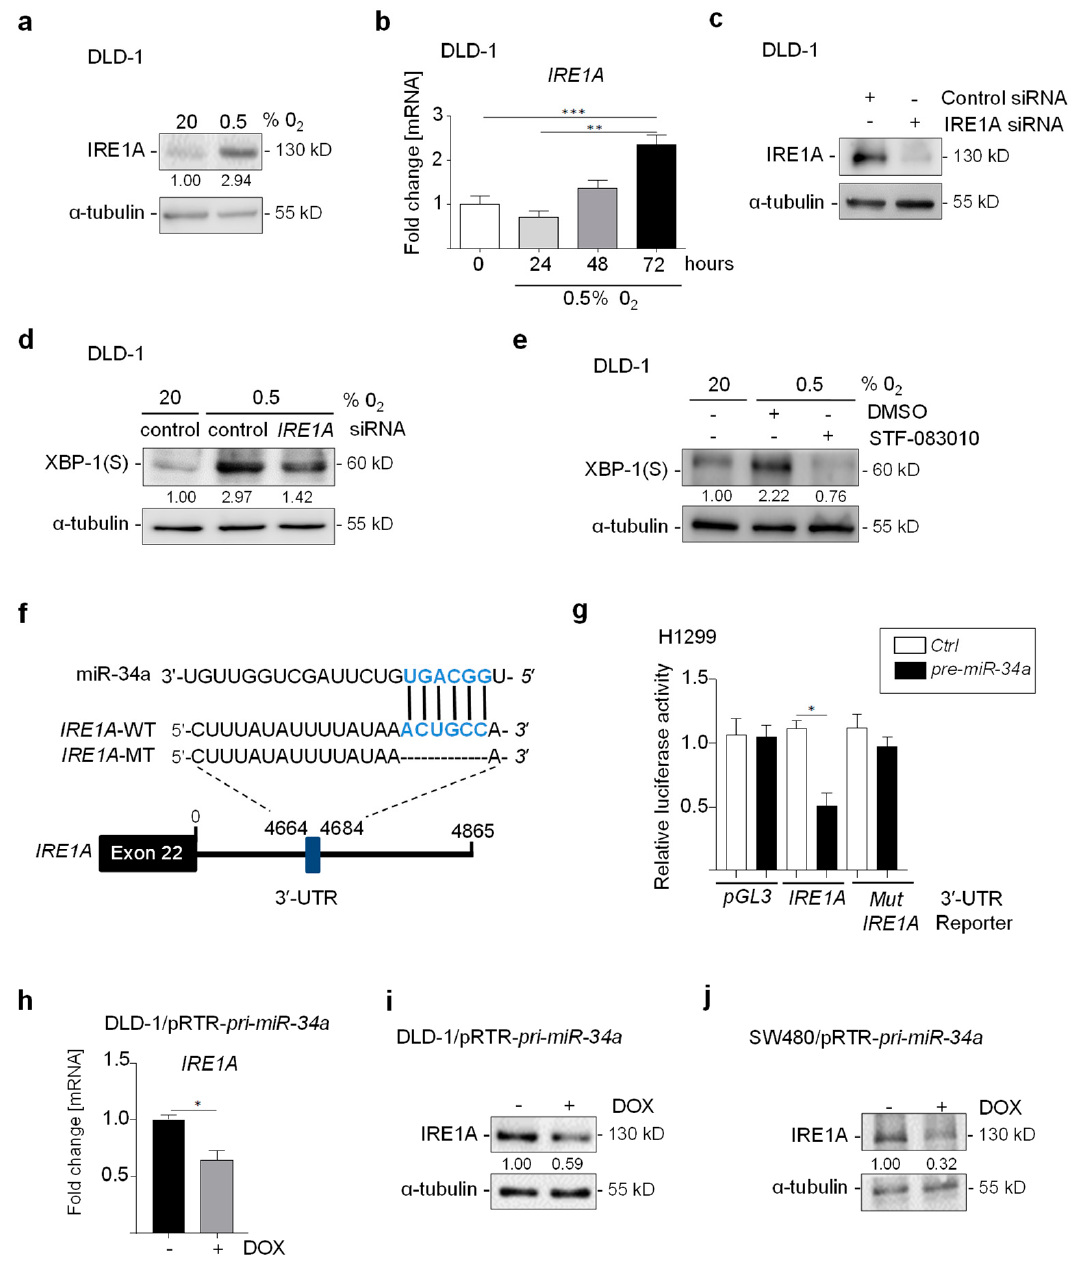
Figure 2. Hypoxia-induced IRE1A is repressed by miR-34a. ( a ) Western blot analysis of IRE1A in DLD-1 cells exposed to 20% or 0.5% O 2 for 48 h. ( b ) qPCR analysis of IRE1A expression in DLD-1 cells exposed to 20% or 0.5% O 2 for the indicated times. ( c ) Western Blot analysis of IRE1A in DLD-1 cells transfected with IRE1A or control siRNAs. ( d ) Western Blot analysis of XBP-1(S) in DLD-1 cells transfected with IRE1A or control siRNAs for 24 h, then cultured at 20% or 0.5% O 2 for 72 h. ( e ) Western blot analysis of XBP-1(S) in DLD-1 cells treated with DMSO or STF-083010 (60 µ M) for 24 h, then cultured at 20% O 2 or 0.5% O 2 for 72 h. ( f ) Schematic representation of the IRE1A 3 (cid:48) -UTR indicating the miR-34a seed-matching sequences (SMS) and mutagenesis. The black vertical bars indicate possible base pairing. ( g ) Dual reporter assay after transfection of H1299 cells with pre-miR-34a oligonucleotides and human IRE1A 3 (cid:48) -UTR reporter constructs. ( h – j ) qPCR and Western blot analysis of IRE1A in DLD-1 and SW480 cells harboring a pRTR/pri-miR-34a vector after addition of DOX for 48 h. In panel ( b , g , h) , mean values ± SD (n = 3) are provided. (***) p < 0.001, (**) p < 0.01, (*) p <